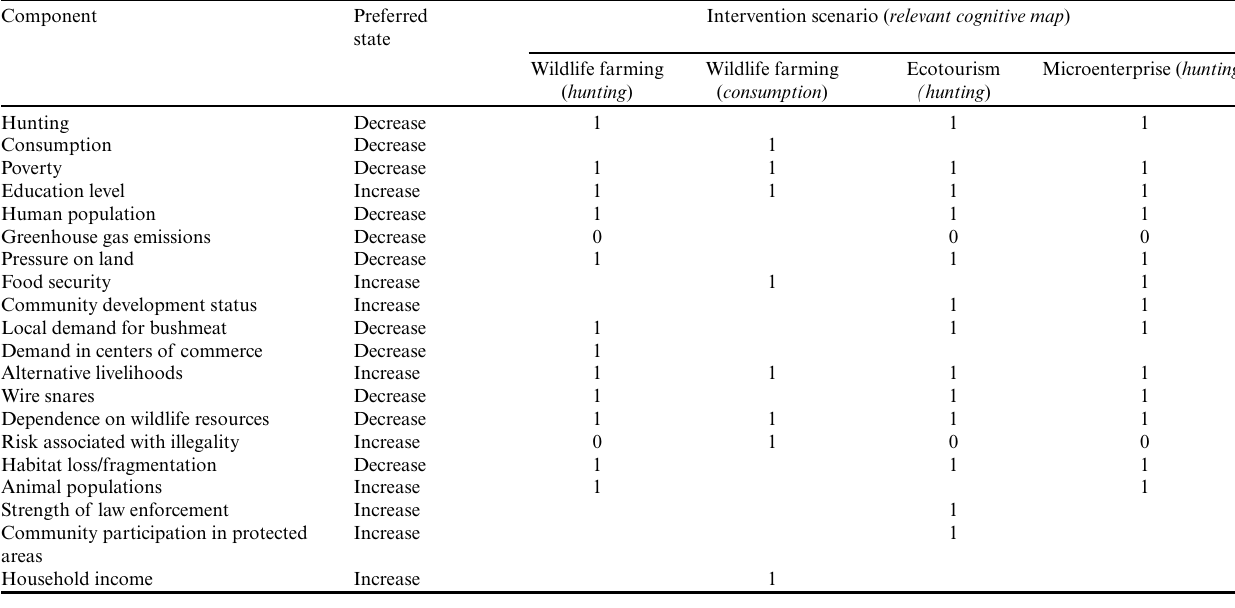
Table 4 . Comparison of whether the outcome of the scenario analysis achieved the preferred state of the component (yes = 1, no = 0), for three hypothetical interventions. The identity of the cognitive map to which the intervention was added (either hunting or consumption) is indicated by italics. Blanks in the table indicate that variable was not affected under the